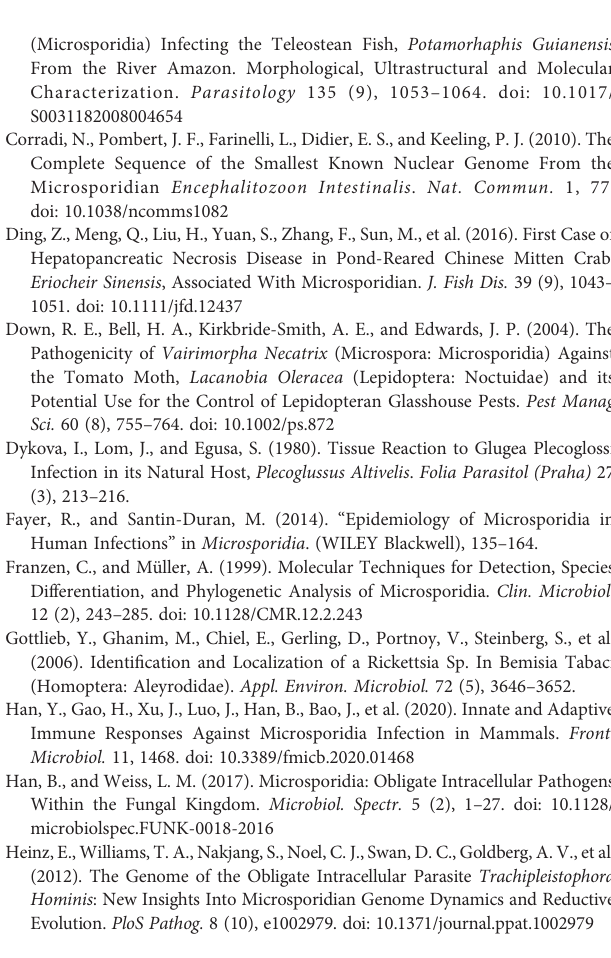
Supplementary Figure 1 | Counting spores with a blood counting chamber. V. necatrix BM spores were puri fi ed from the fi fth-day pupae for counting the spore production. The spores were diluted ×500 and added to the counting chamber. Spores in fi ve middle-sized grids in the four corners and center were